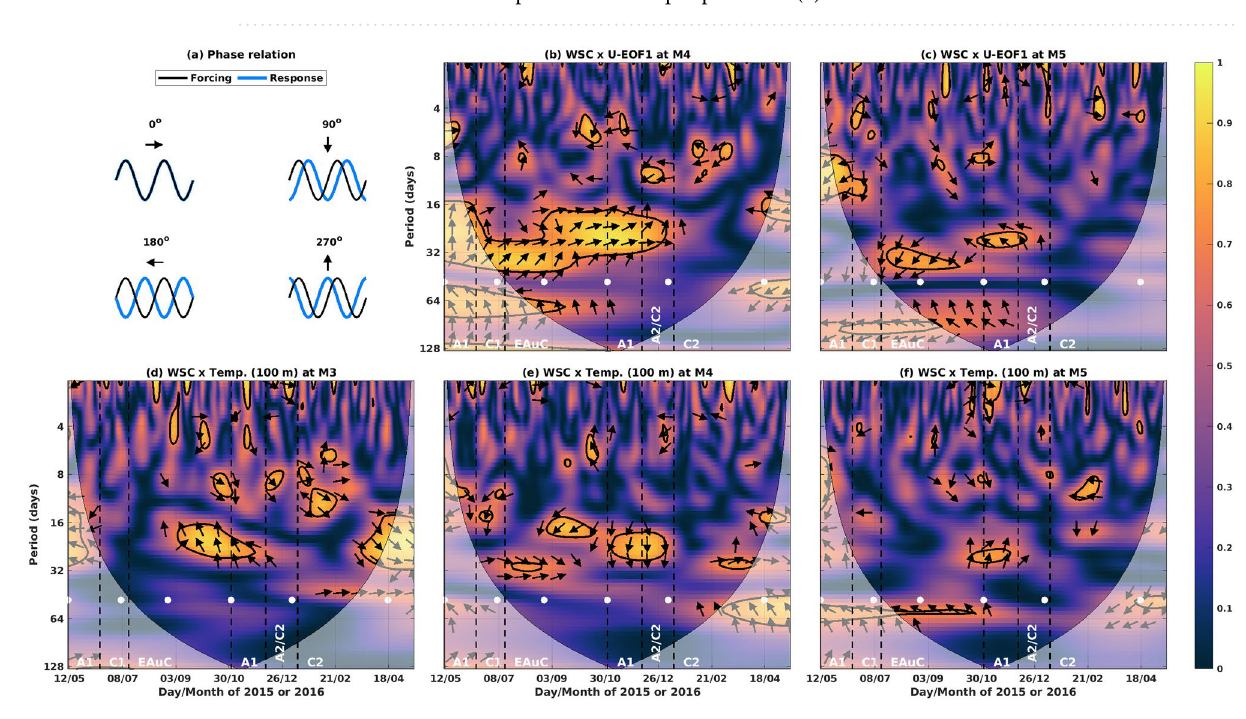
Figure 8. Same as Fig. 7 but for coherency with